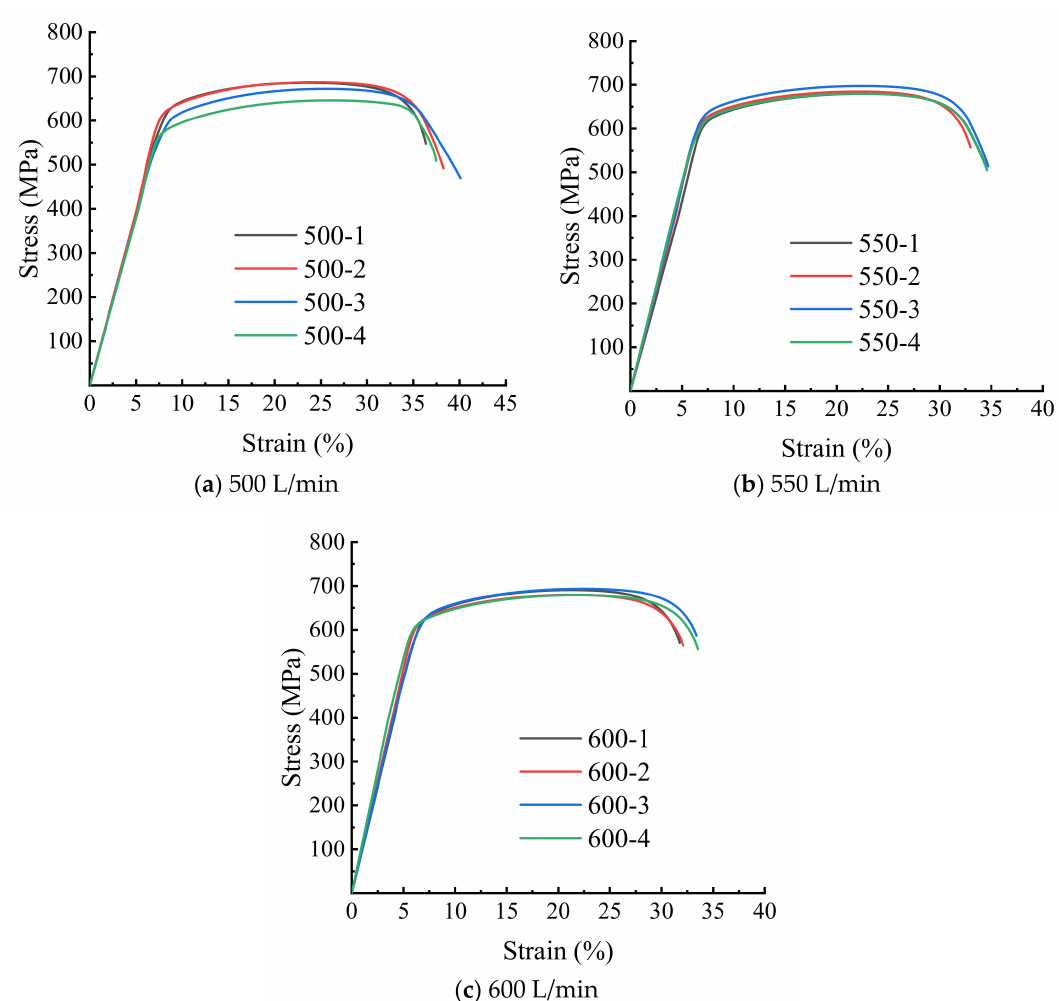
Figure 9. The uniaxial tensile test stress-strain curves of 316L sample fabricated with different shielding gas volume